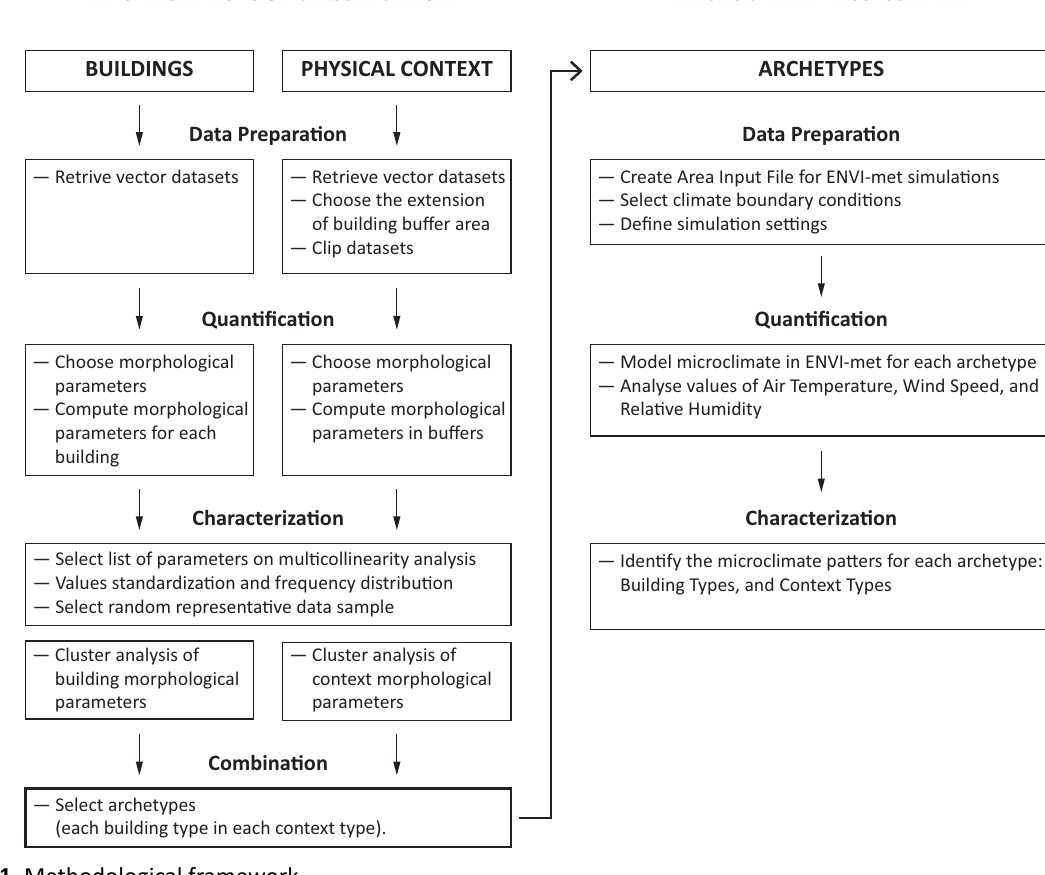
Figure 1. Methodological framework. microclimate performance, dependent upon form char‐ acteristics of building types and context types, and con‐ clusions are